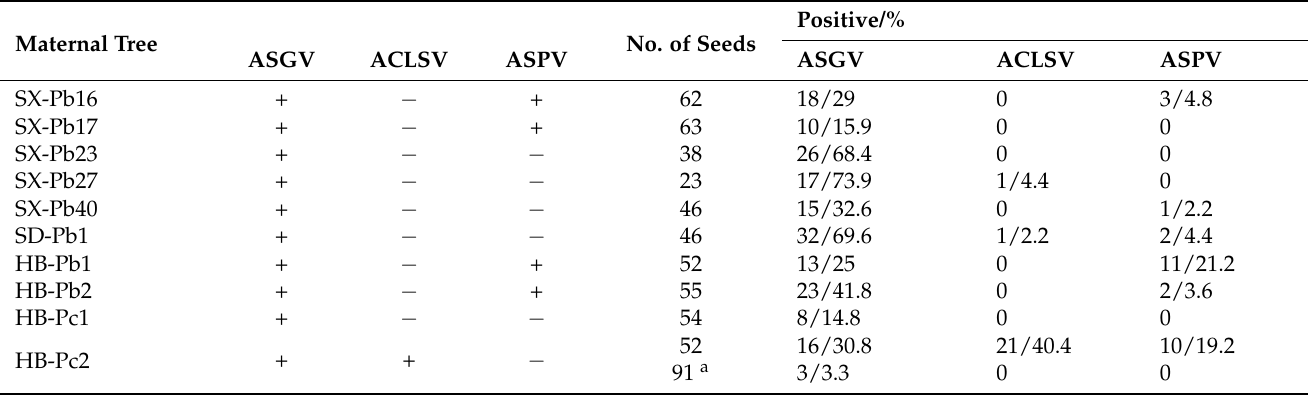
Table 3. The seed borne frequencies of three viruses infecting P. betulaefolia and P. calleryana .